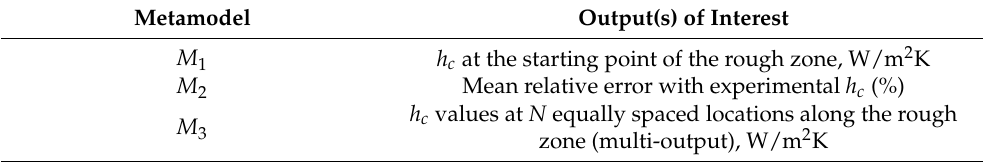
Table 2. The metamodels created.